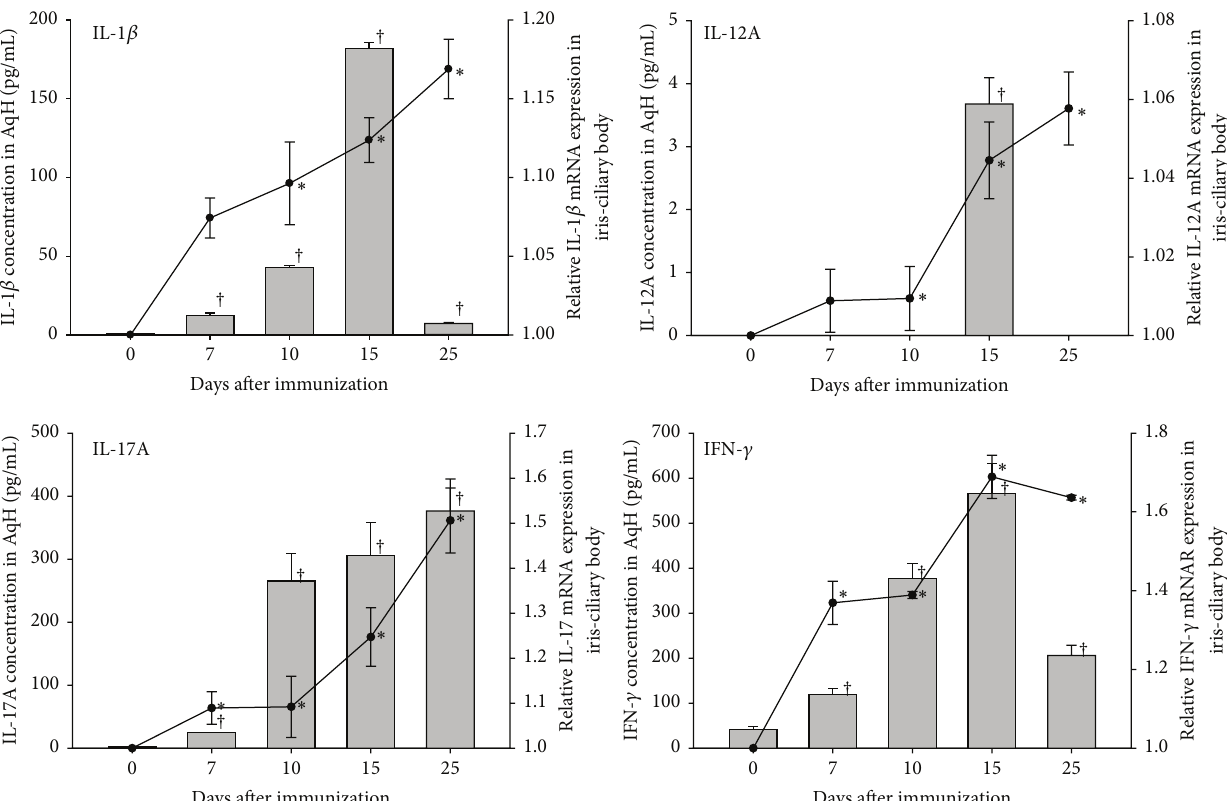
Figure 6: Cytokine concentrations in the aqueous humor and corresponding mRNA expression in iris/ciliary bodies following induction of EAAU. Cytokine concentrations are shown in the bar charts, while the relative mRNA expression is represented by the line graphs; ∗ cytokine concentration with significant difference ( 𝑃 < 0.05 ) among the study and control groups; † cytokine-related mRNA expression with significant difference ( 𝑃 < 0.05 ) among the study and control